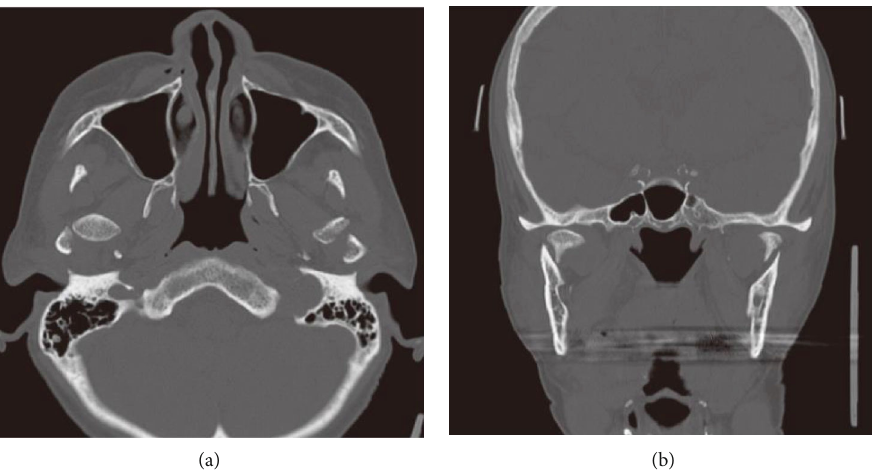
Figure 3: CT fi ndings: (a) sagittal reconstruction of CT images and (b) coronal reconstruction of CT images. The bilateral condylar fractures were observed.